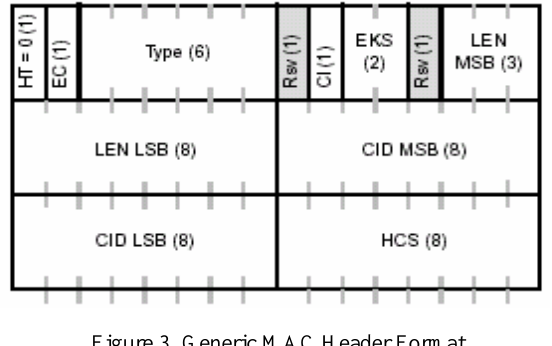
Figure 3. Generic MAC Header